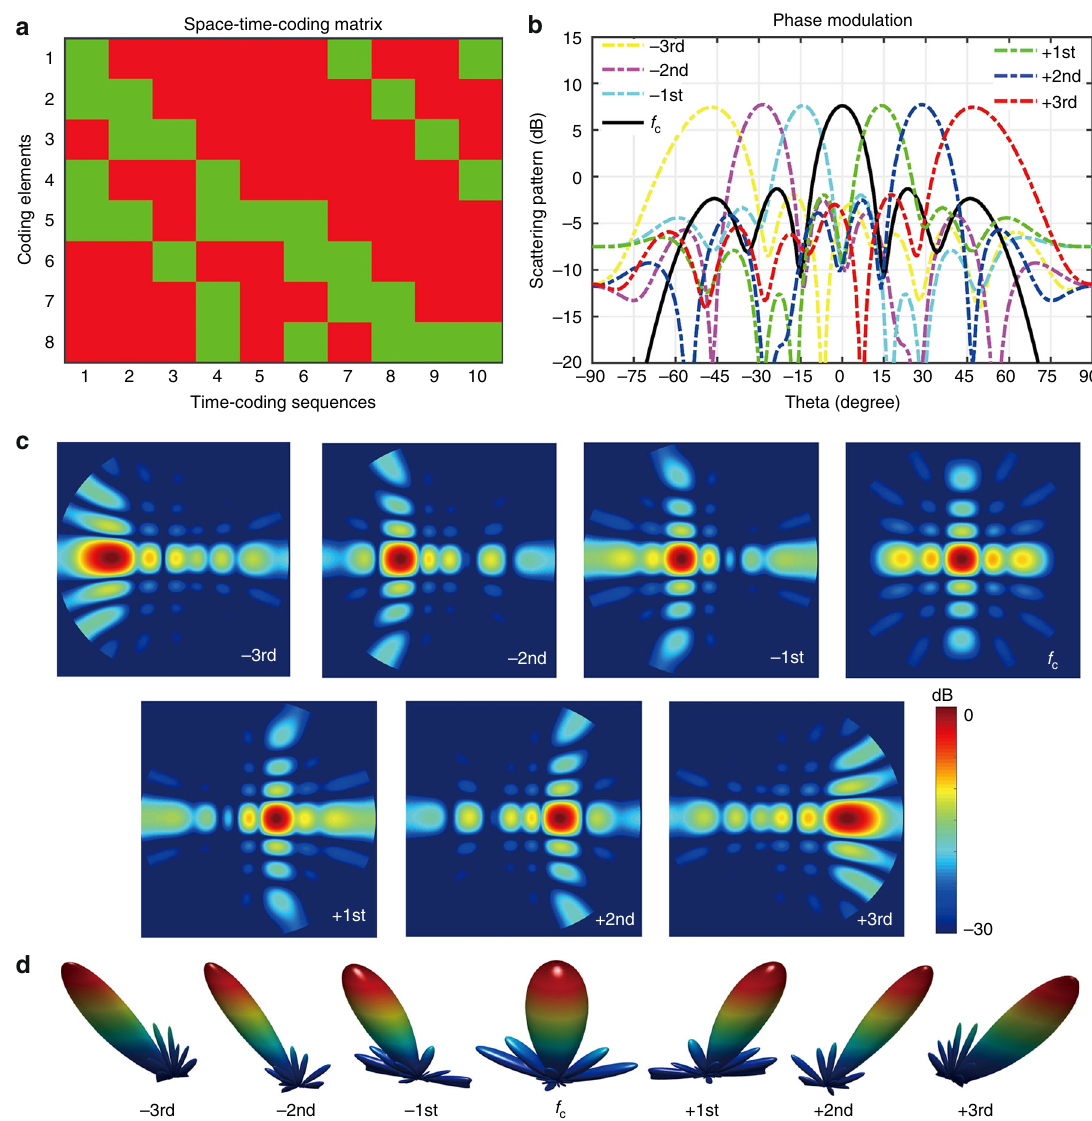
Fig. 3 BPSO-optimized harmonic beam steering. a Optimized 2D space-time-coding matrix. b , c , d Corresponding 1D scattering-pattern cuts at φ = 90°, 2D, and 3D scattering patterns, respectively, at different harmonic